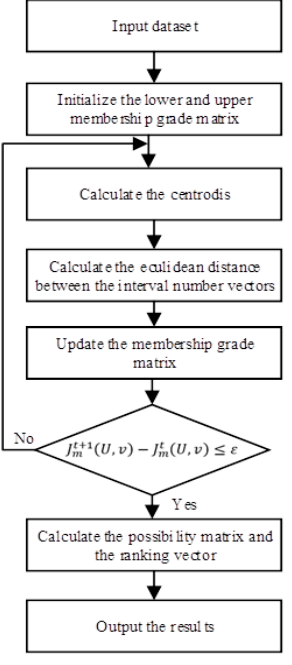
Figure 4. The flowchart of the modified IT2FCM* algorithm.